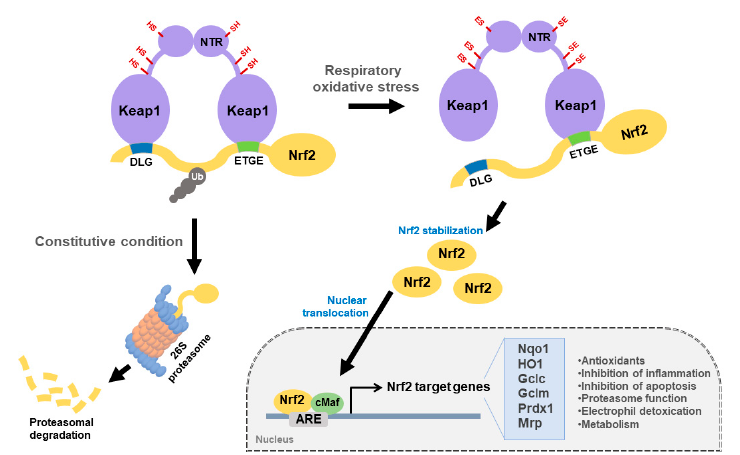
Figure 1. The Keap1-Nrf2 signaling pathway. Nrf2, a transcription factor, contributes to expression of cell-protective genes in response to respiratory oxidative stress. Keap1 is a regulatory protein that inhibits activation of Nrf2. Under Constitutional condition, Nrf2 remains bound to Keap1 and is degraded by the ubiquitin-proteasome pathway dependent on keap1. In respiratory oxidative stress environment, Keap1 is inactivated while Nrf2 is stabilized. The stabilized Nrf2 performs nuclear translocation and heterodimerizes with cMaf to activate target genes for cell protection through ARE. Nrf2 target genes include NAD(P)H quinone oxidoreductase 1 (Nqo1), heme oxygenase 1 (HO1), glutamate-cysteine ligase catalytic subunit (Gclc), glutamate-cysteine ligase modifier subunit (Gclm), Peroxiredoxin 1 (Prdx1), and Multidrug resistance-associated protein (Mrp) and perform antioxidants, inhibition of inflammation, inhibition of apoptosis, Proteasome function, electrophile detoxication, and metabolism.